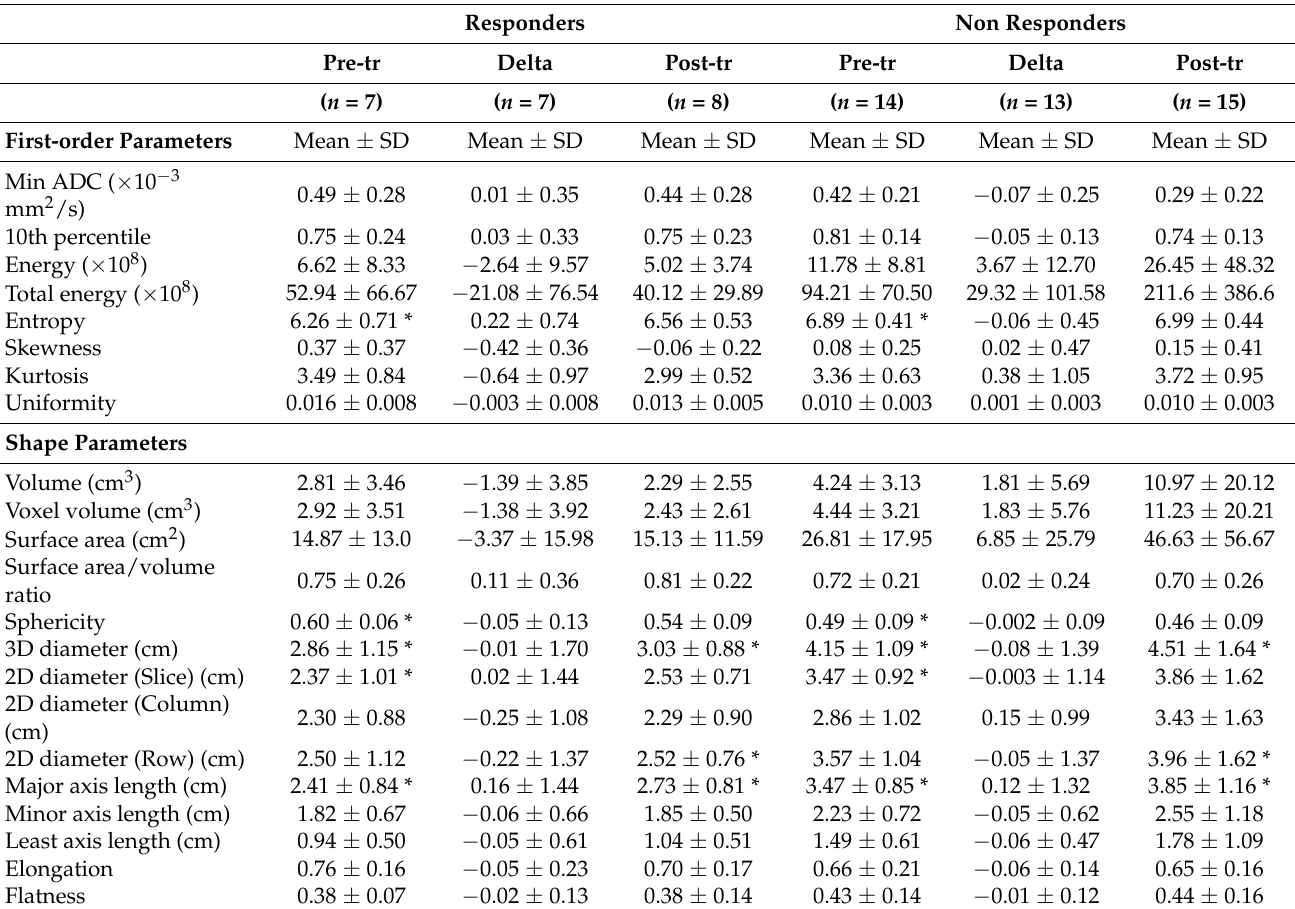
Table 2. Mean value of responding and non-responding tumor features at pre- and post-treatment timing, and the calculated delta features using the patients with data available at both time points. Pre-tr: pre-treatment, On-tr: post-treatment. *: Significant in analyses in Table 3. Mean of Responding and Non-Responding Tumor Features at Pre- and Post-Treatment and the Calculated